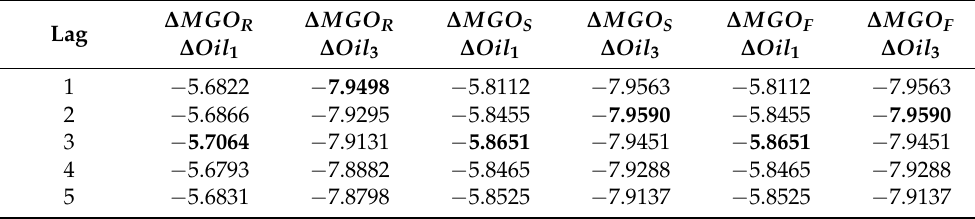
Table 4. Lag selection using Bayesian information